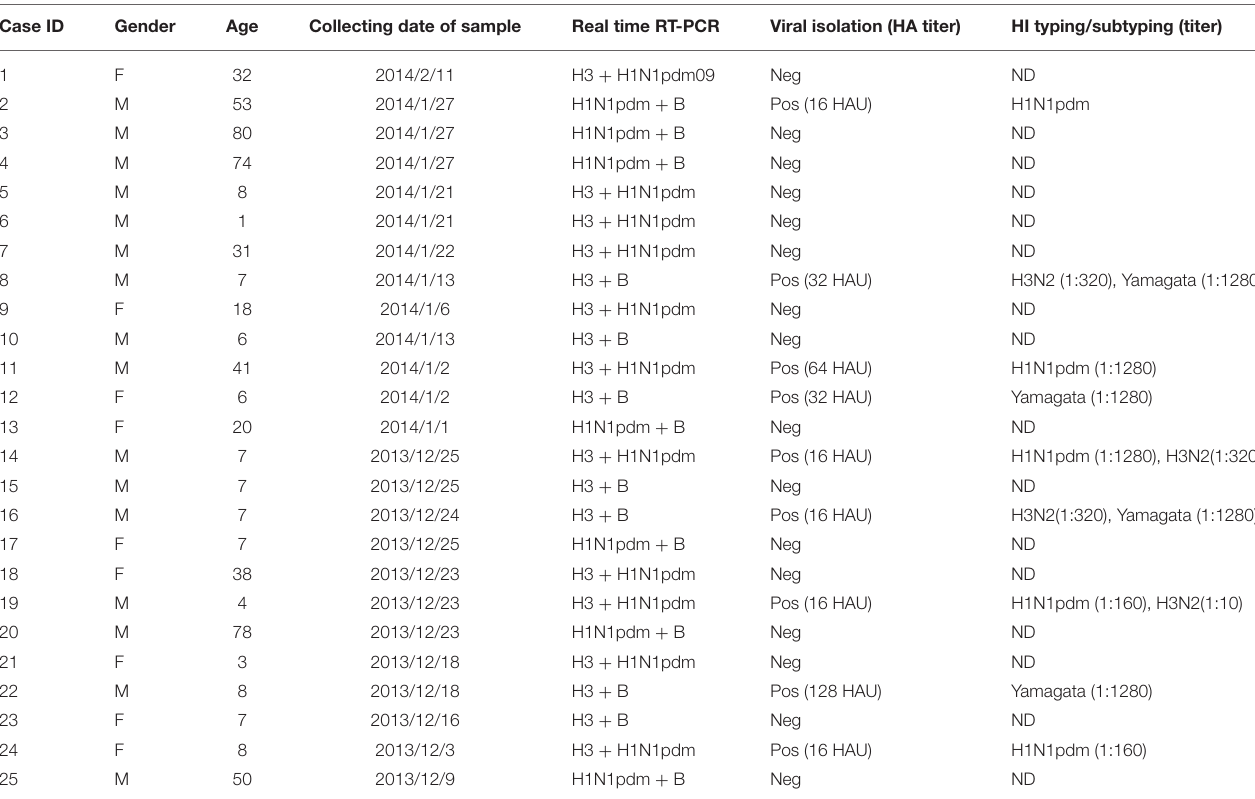
TABLE 1 | Co-infection with influenza A and B in ILI patients enrolled. Case ID Real time RT-PCR Viral isolation (HA